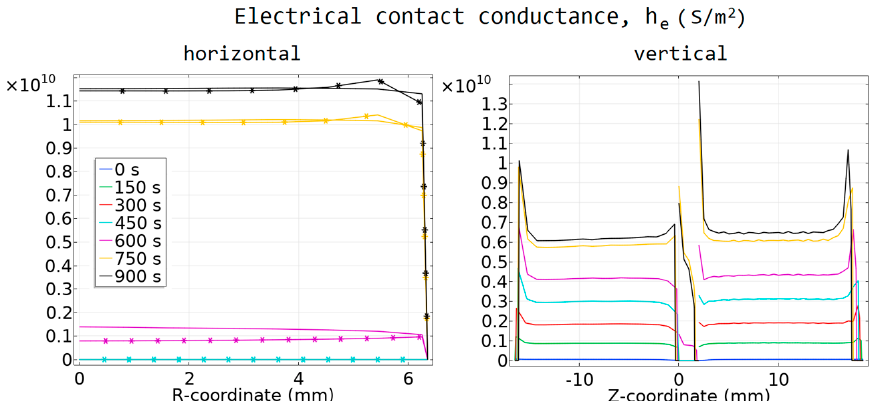
Figure 7. Electrical conductance of the contacts. ( a ) Contacts IV and V; asterisk markers correspond to the contact IV, solid line to contact V. ( b ) Contacts I–III.